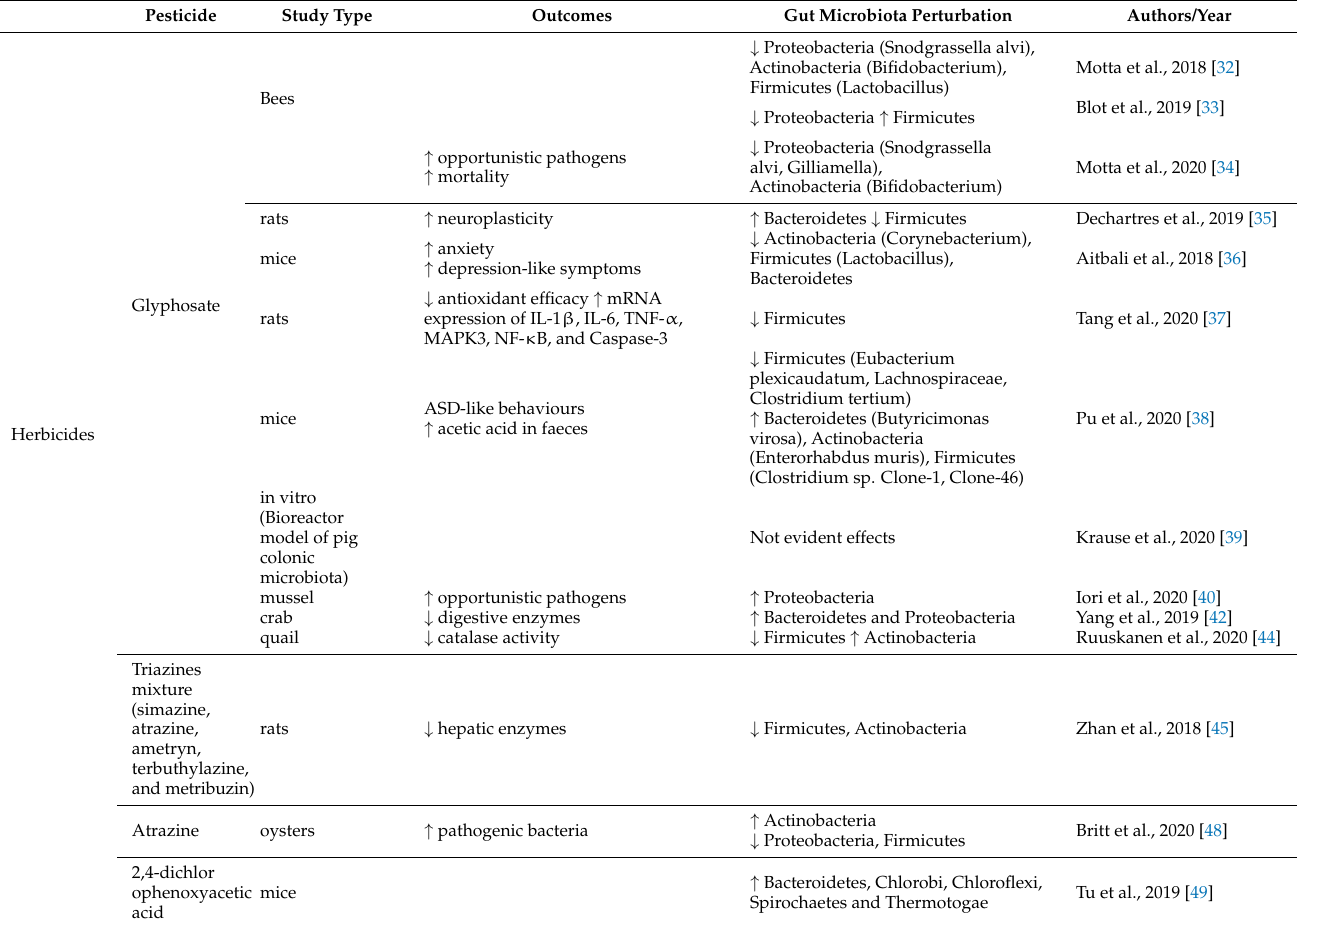
Table A1. Current literature on gut microbiota perturbation due to exposure to